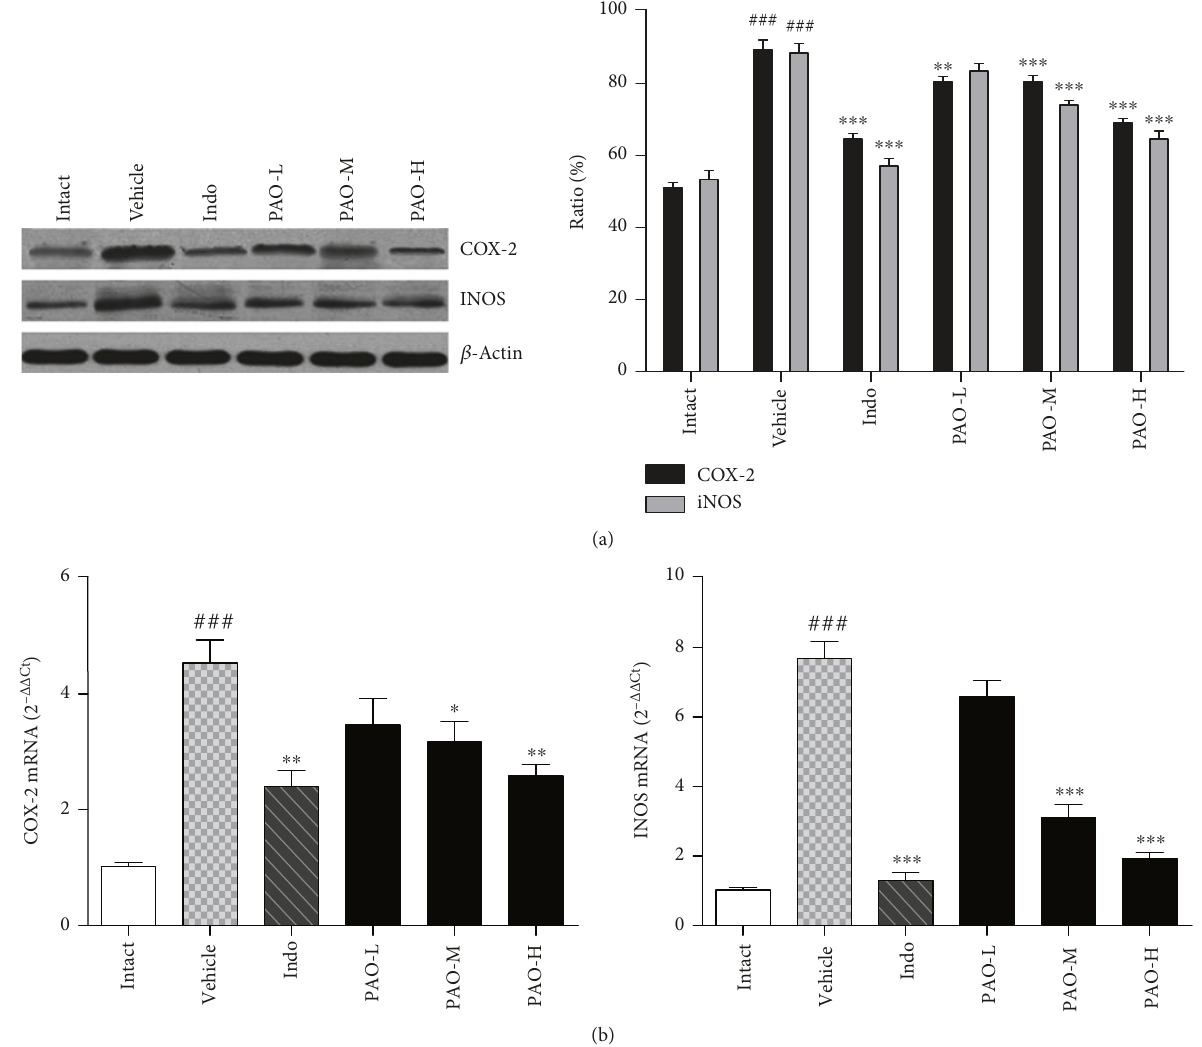
Figure 8: E ff ect of PAO on the protein and mRNA expressions of COX-2 and iNOS in carrageenan-induced mouse paw. Indo: indomethacin (10 mg/kg); PAO-L: low dose of PAO (10 mg/kg); PAO-M: medium dose of PAO (20 mg/kg); PAO-H: high dose of PAO (40 mg/kg). (a) Protein expression of COX-2 and iNOS was measured by Western blot analysis. β -Actin was used as a loading control. (b) E ff ect of PAO on COX-2 and iNOS mRNA expression. Total RNA was isolated and analyzed for mRNA expression via RT-PCR. Data were expressed as means ± SEM. ( n = 3 ), ### p < 0 001 versus the intact group. ∗ p < 0 05 , ∗∗ p < 0 01 , and ∗∗∗ p < 0 001 versus the vehicle